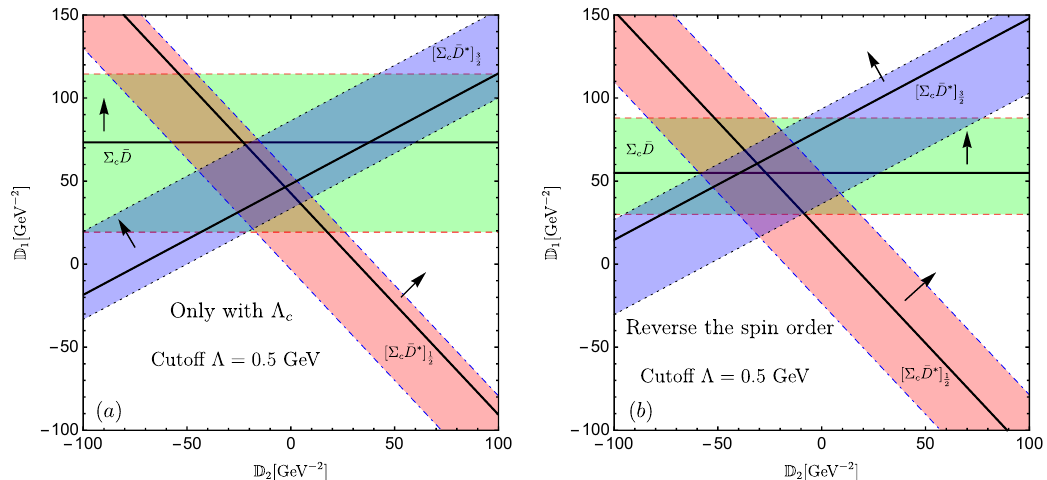
Figure 12 . The dependence of the binding energies of the three P c states on the rede(cid:12)ned LECs D D 1 and 2 in di(cid:11)erent cases. Figure ( a ) gives the result that only considering the contributions of (cid:3) c in the two-pion-exchange diagrams. Figure ( b ) shows the result when interchanging the spins of P c (4440) and P c (4457). The notations are the same as those in (cid:12)gure